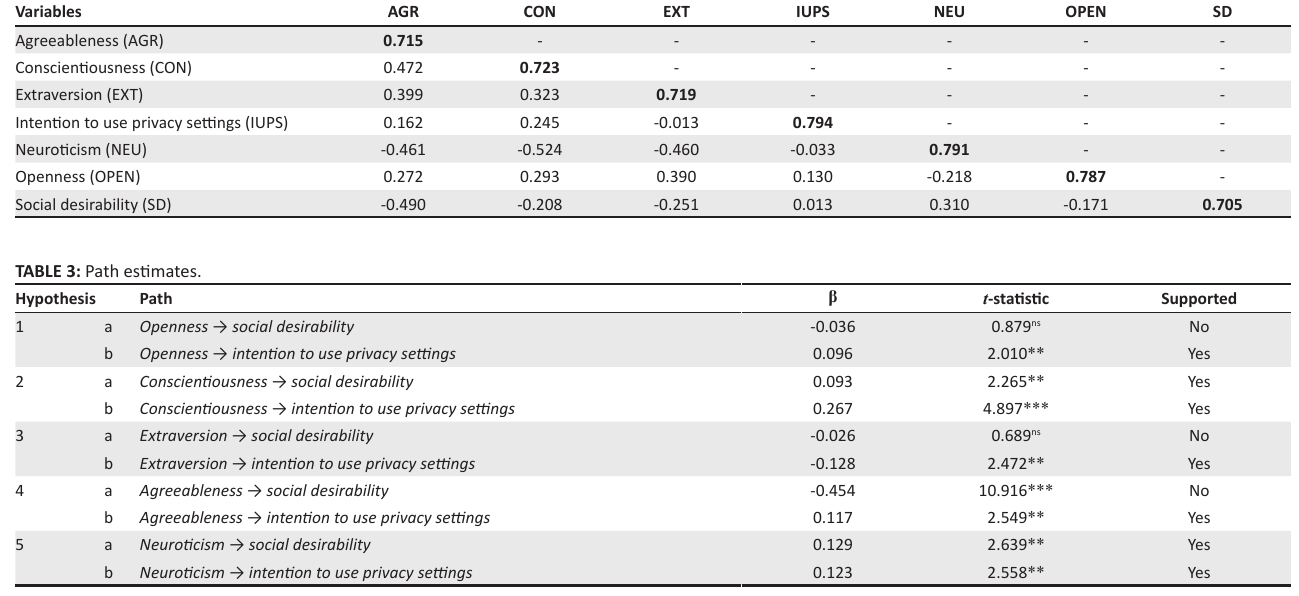
TABLE 2: Measurement model statistics. Variables